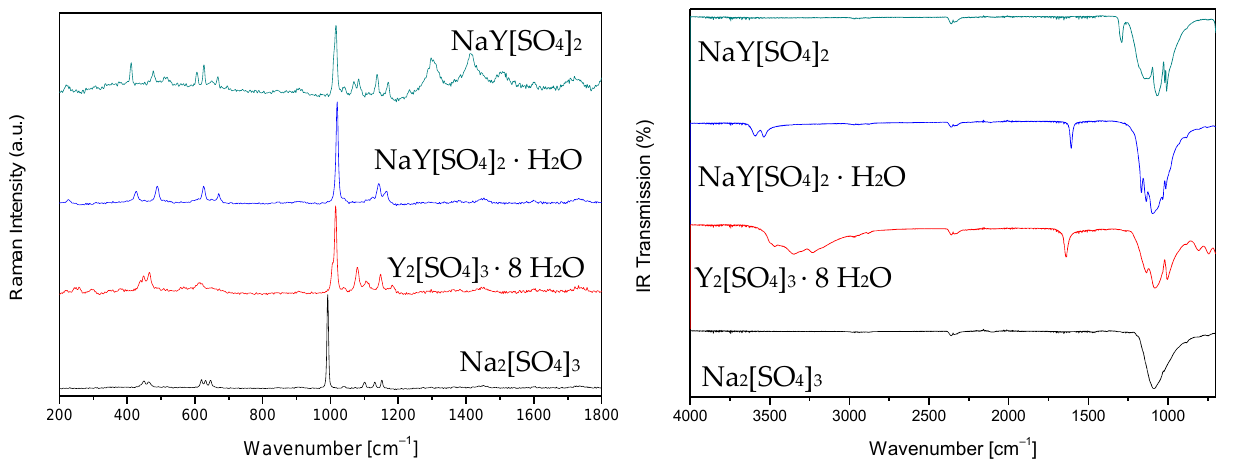
Figure 17. Temperature-dependent decay curves of NaY[SO 4 ] 2 ∙H 2 O:Eu 3+ ( top ) and NaY[SO 4 ] 2 :Eu 3+ ( bottom ) between 100 and 500 K upon 395 nm excitation.